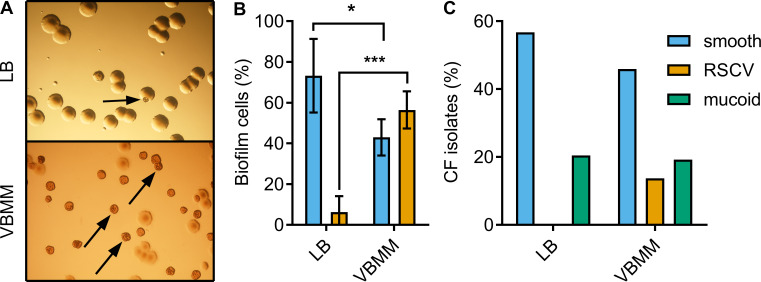
RSCVs are abundant in P. aeruginosa biofilms and among CF isolates.(A) An aliquot of cells recovered from a single drip-flow reactor biofilm was plated onto LB or VBMM agar. The arrows indicate representative RSCVs from each sample. Each panel represents an area that is approximately 22.9 mm × 16.0 mm. (B) Proportion of RSCV and ancestral smooth colony morphotypes on LB and VBMM agar. Each bar indicates the mean and standard deviation for 6 independent drip-flow reactors. *P<0.05 and ***P ≤ 0.001 colony counts on LB vs. VBMM agar with Student’s t-test. (C) A total of 416 P. aeruginosa isolates acquired from a study of CF respiratory epidemiology were streaked on LB or VBMM-based agar (see S1 Text) and scored for colony morphology. The percentage of isolates with the indicated colony morphologies is illustrated.